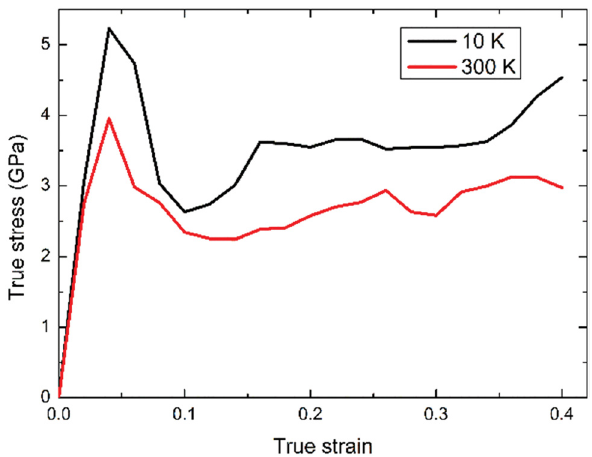
Figure 12: Temperature e ff ect on the stress – strain